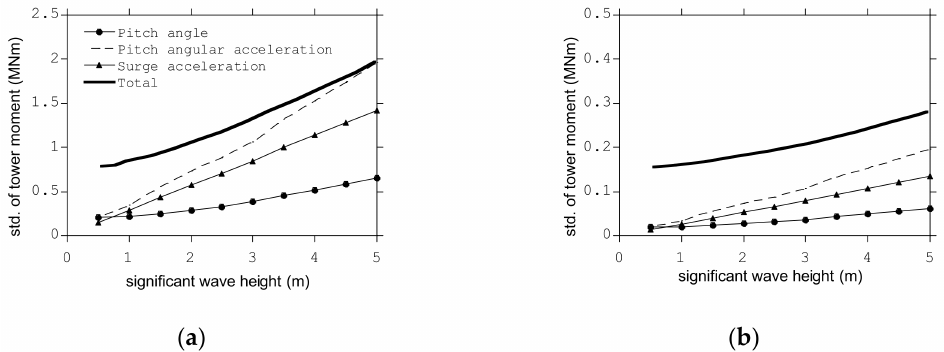
Figure 9. Standard deviation of fore-aft tower bending moments as function of significant wave height at ( a ) tower base and ( b ) tower top.